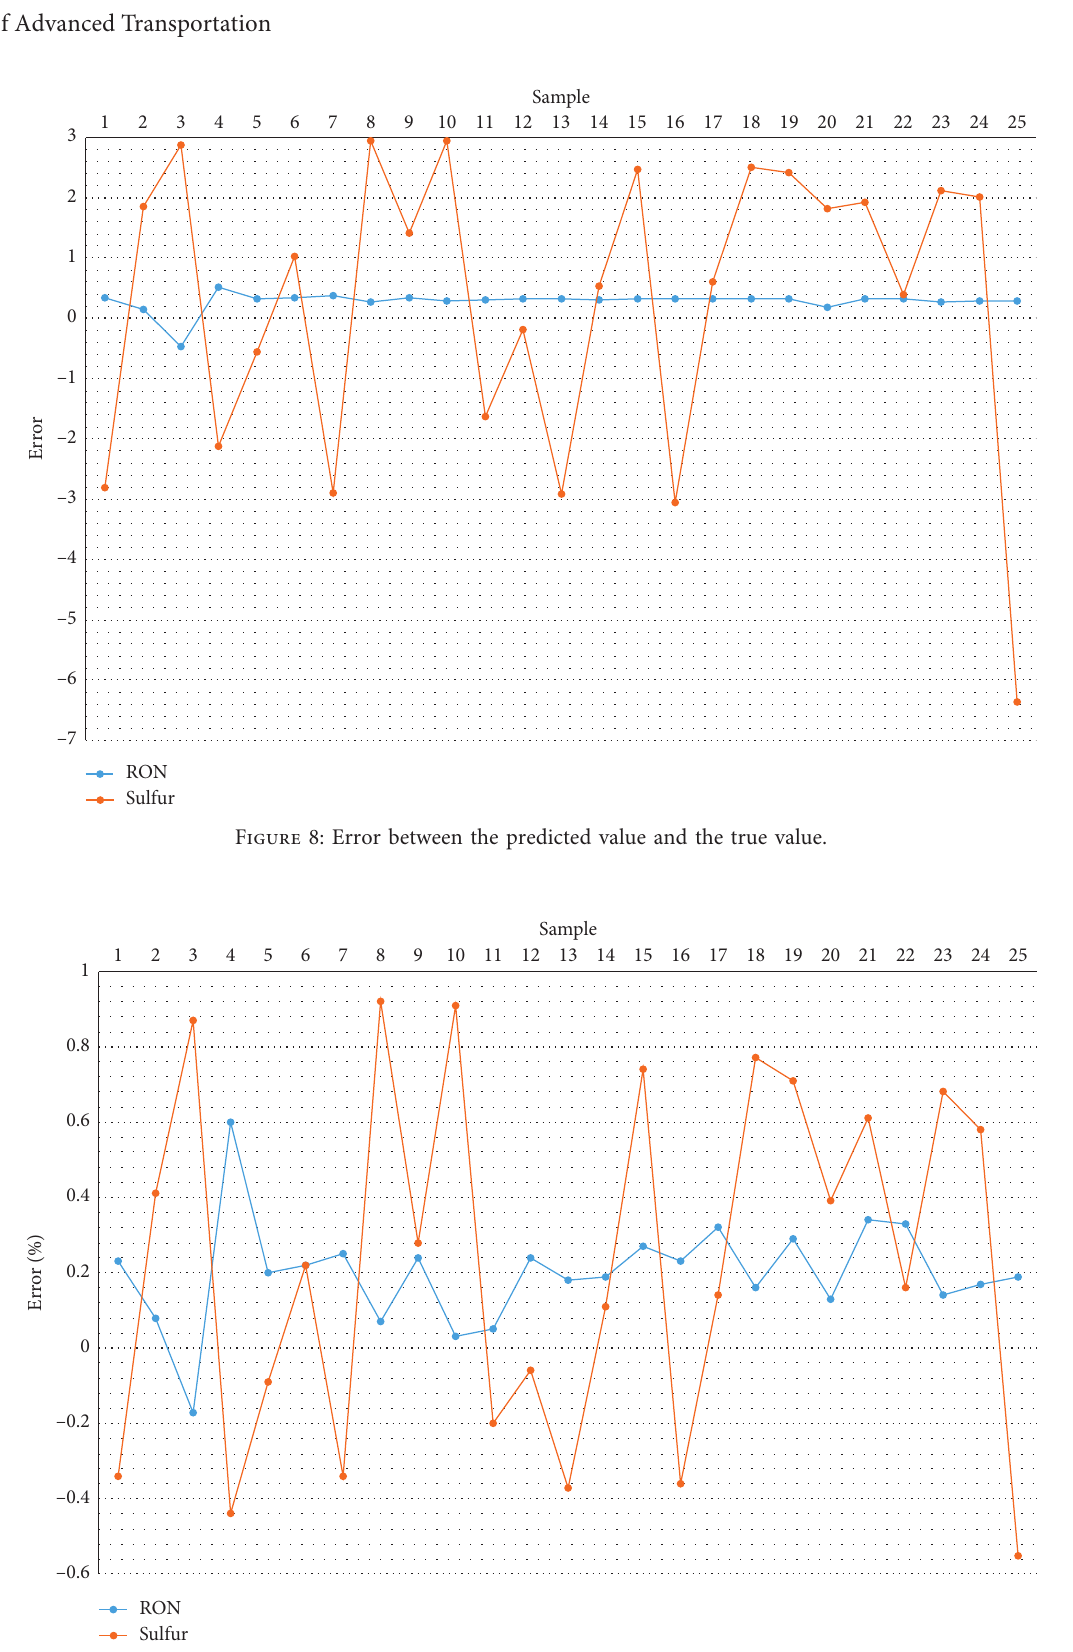
Figure 9: Error percentage between the predicted value and the true